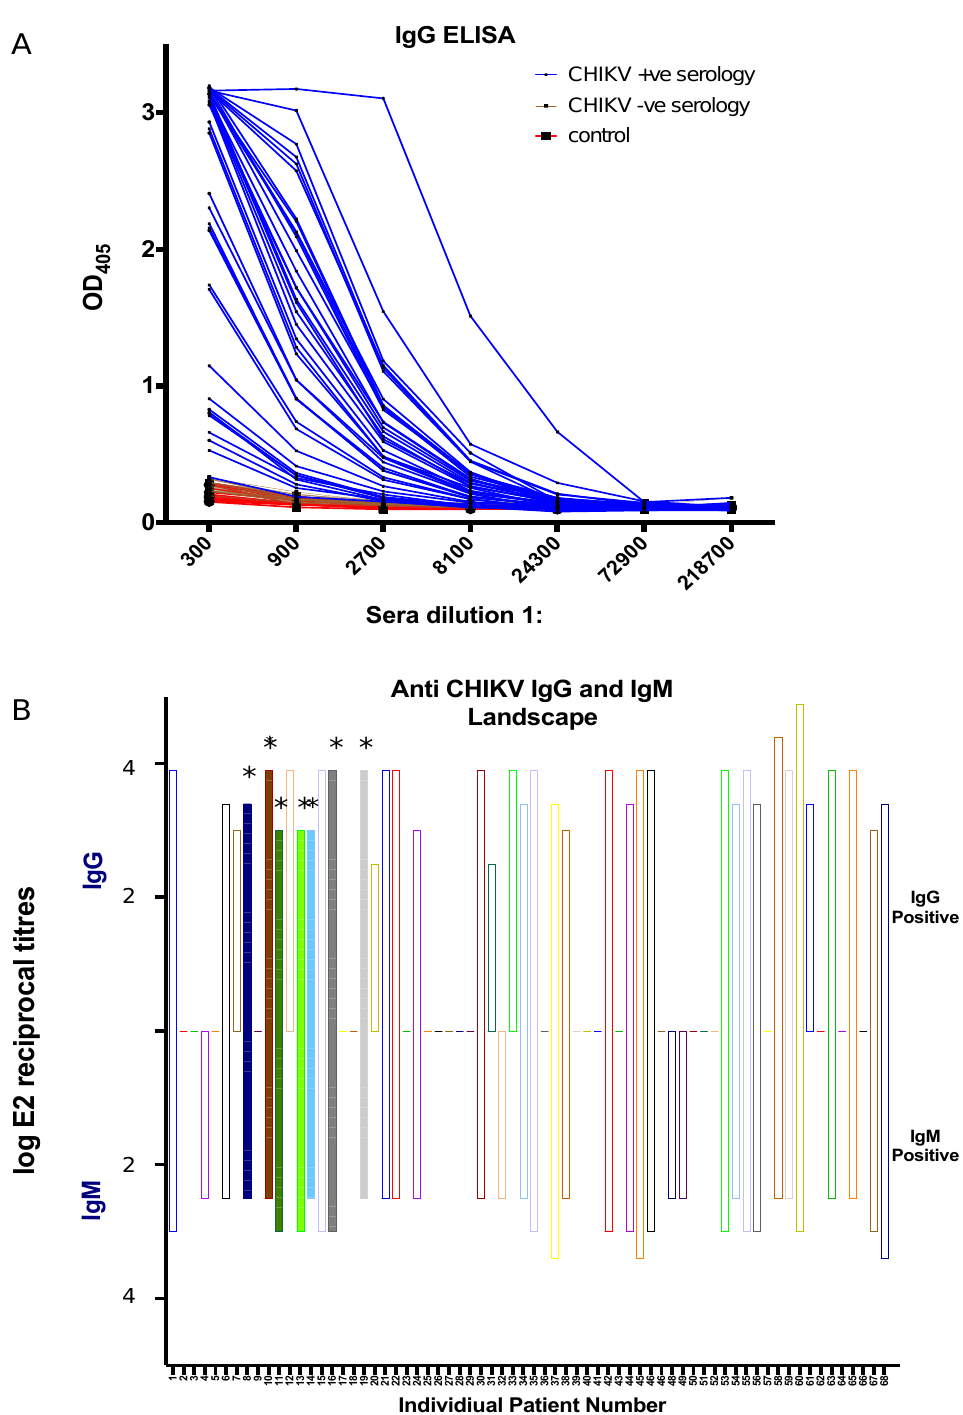
Figure 5. In-house recombinant CHIKV envelope protein 2 (E2)-based ELISA. ( A ) IgG ELISA assay to assess the reactivity of all the human serum samples in this study. Positive CHIKV serology (blue), negative CHIKV serology (brown), and negative control serum samples from healthy volunteers (red). ( B ) Log reciprocal E2 endpoint titres for IgG (positive y -axis) and IgM (negative y -axis) are represented for all 68 serum samples. RT-PCR positive samples are indicated by the (*) and color-filled bars.